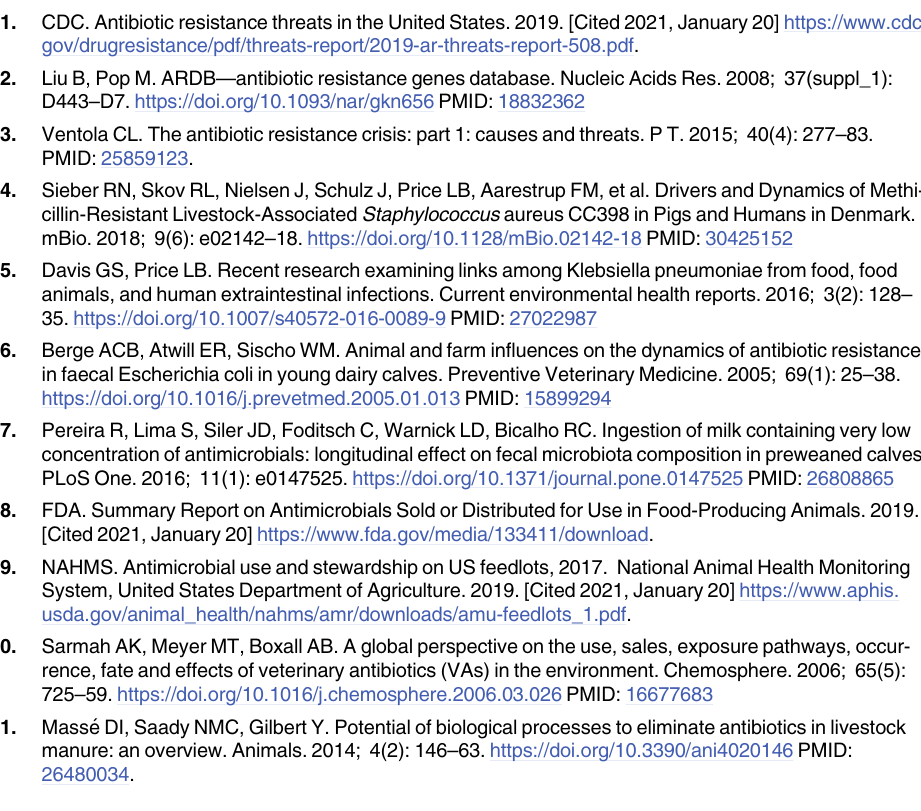
S4 Table. Gene RA reductions on Day 5 and Day 30 compared with Day 0. Numbers are in log